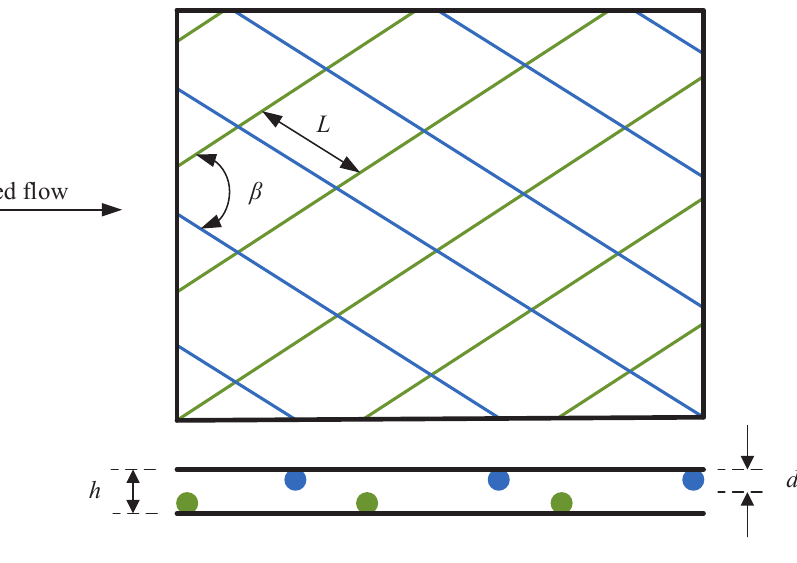
Figure 1. Parameters of feed spacer geometries. Table 2. Correlation between λ and Re number